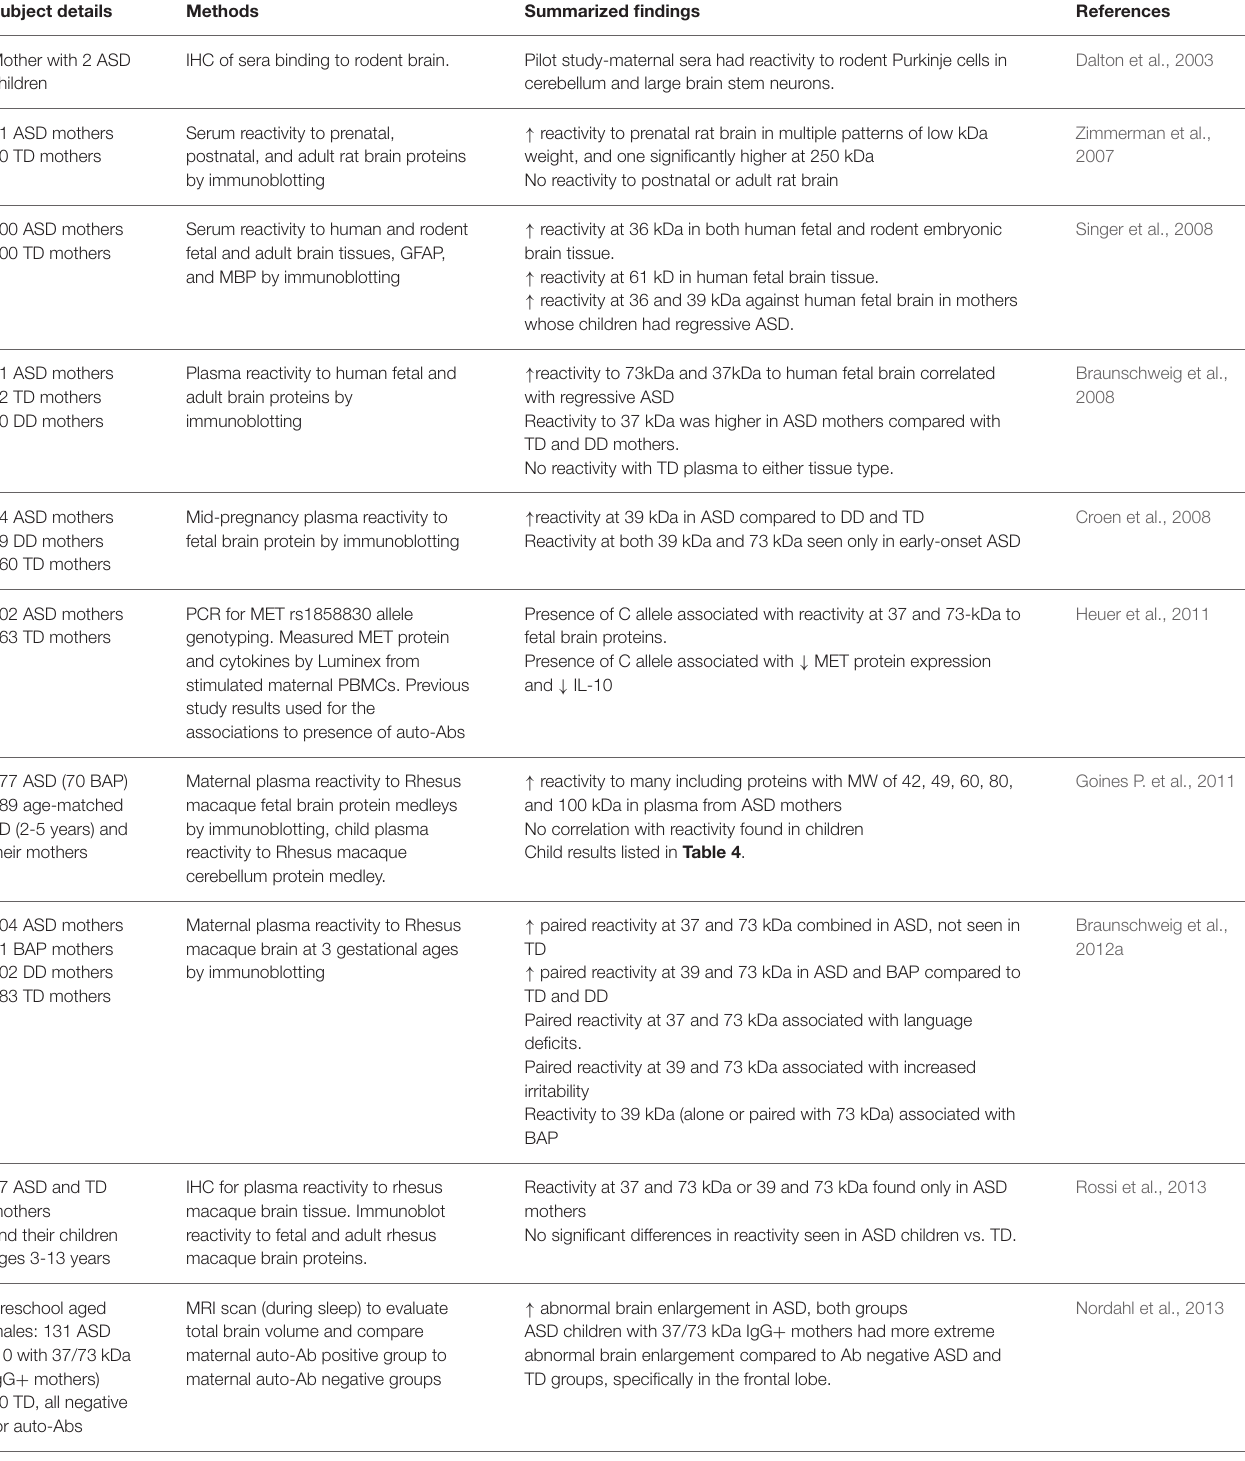
TABLE 2 | Studies identifying presence of anti-brain autoantibodies in mothers of children with